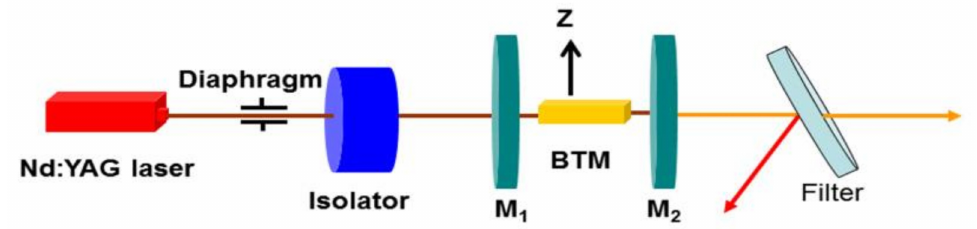
Figure 10. Schematic diagram of the BaTeMo 2 O 9 ( BTM) self-frequency-doubled Raman laser at 589 nm